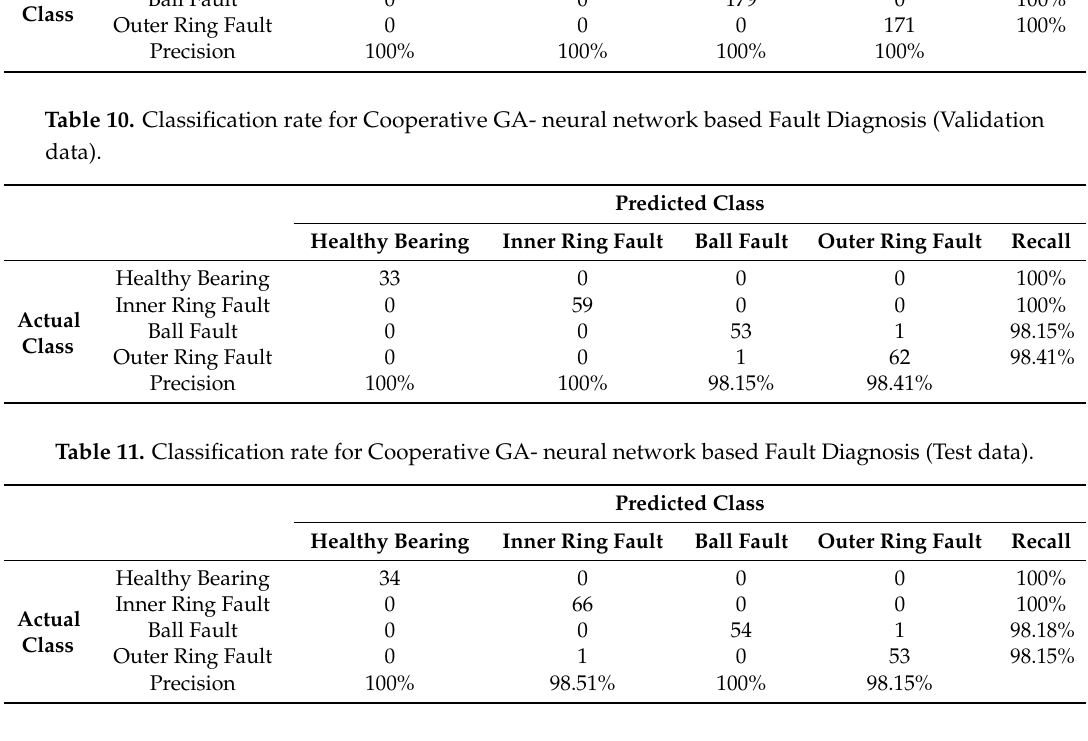
Table 10. Classification rate for Cooperative GA- neural network based Fault Diagnosis (Validation